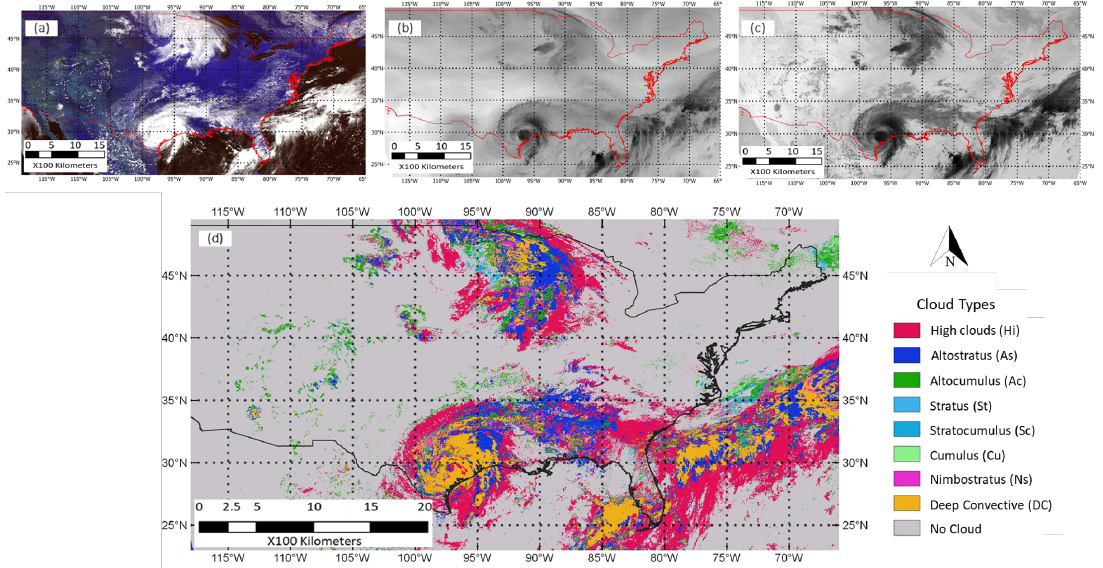
Figure 3. Visualization of ( a ) visible bands (0.47 µ m, 0.64 µ m, 0.86 µ m), ( b ) Midlevel Water Vapor Band (6.9 µ m), ( c ) infrared band (10.3 µ m) and ( d ) DeepCTC output from the GOES-16 ABI images, Hurricane Harvey event 26 August 2017 at 17:32